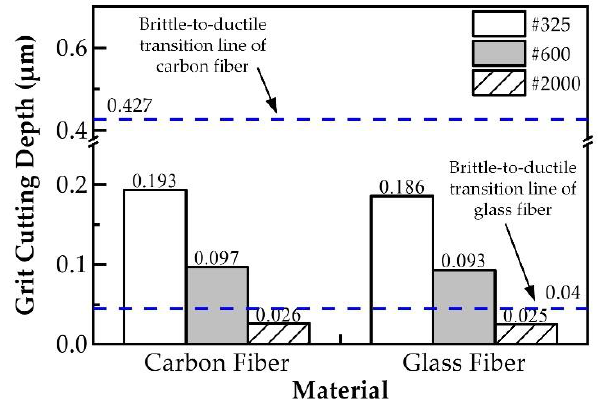
Figure 11. Comparing the cutting depth of the fiber brittle-to-ductile transition with the grit cutting depth of different grinding wheels.